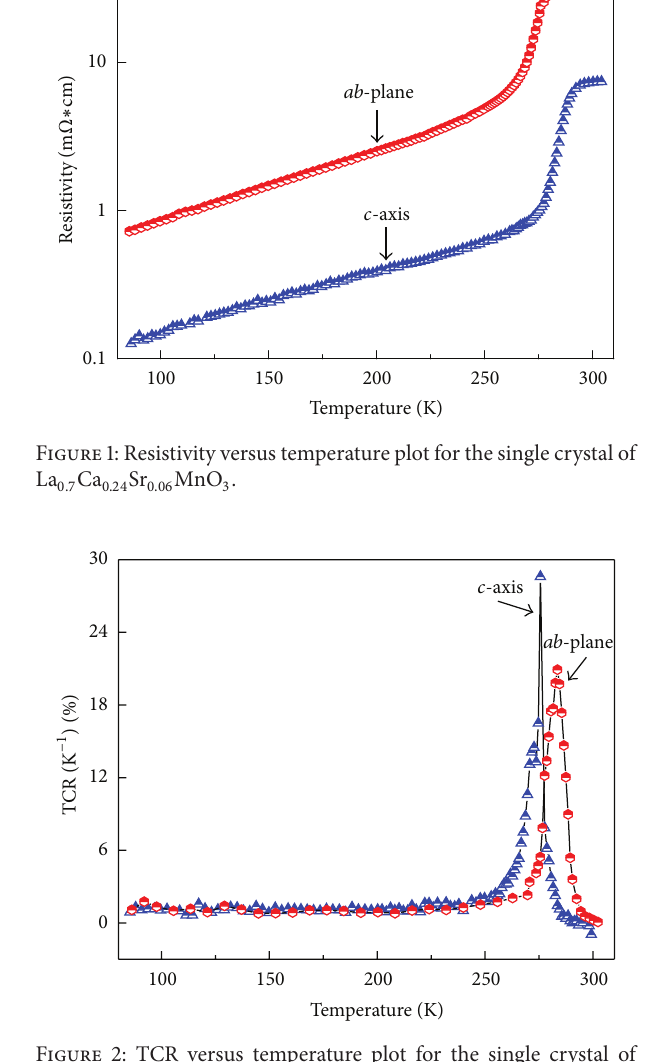
Figure 2: TCR versus temperature plot for the single crystal of La 0.7 Ca 0.24 Sr 0.06 MnO 3 , along ab -plane and along c-